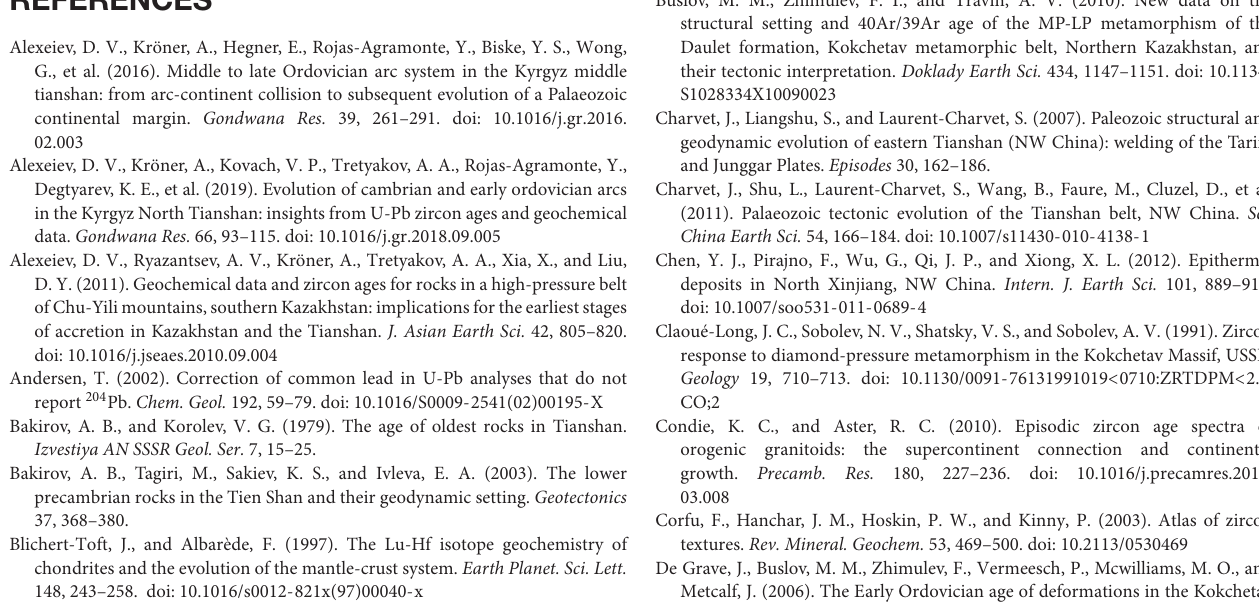
Supplementary Table 4 | Available geochronological data from rocks from the Aktyuz